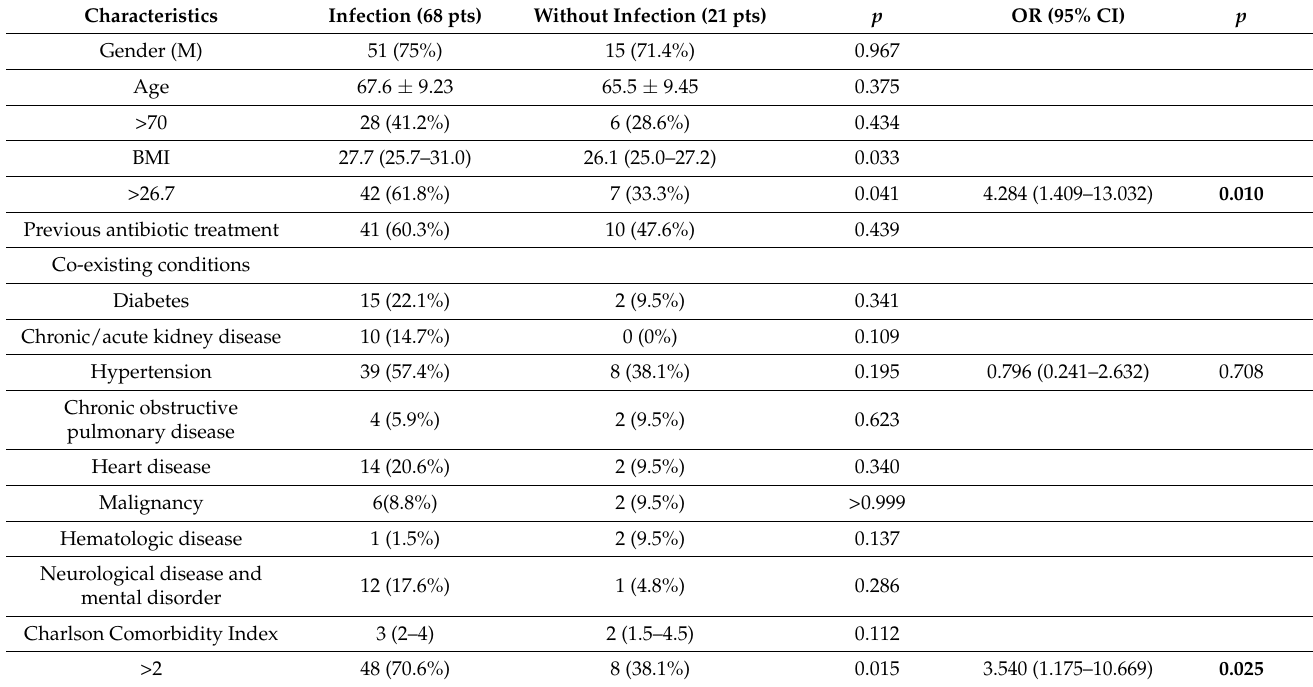
Table 2. Risk factors for the onset of secondary